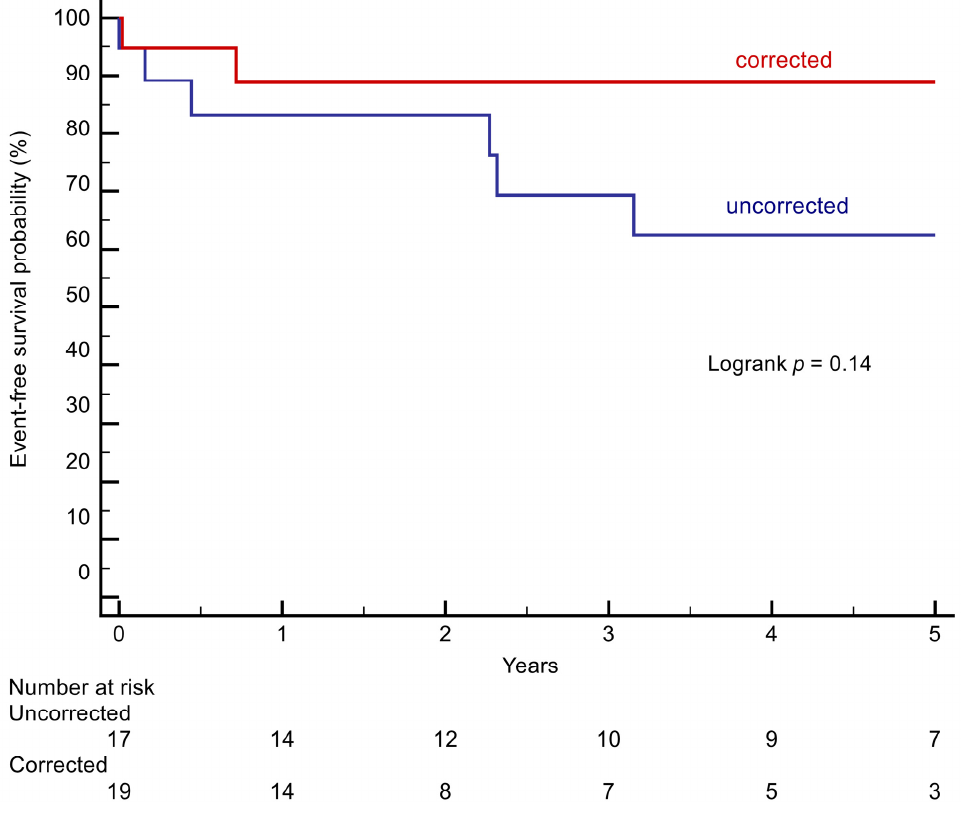
Figure 2. Kaplan–Meier curves comparing patients with a corrected cAVSD with uncorrected